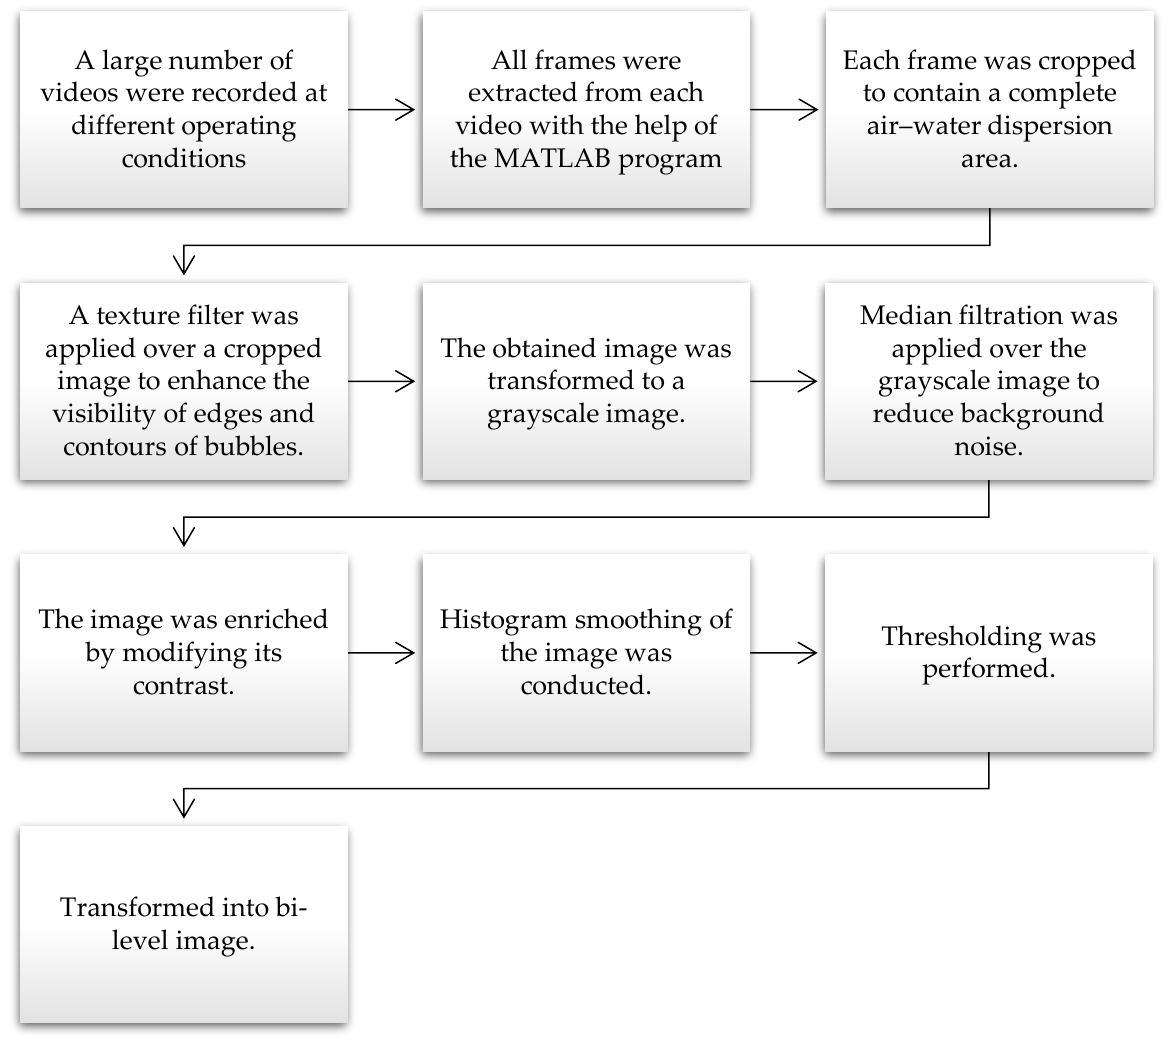
Figure 3. Steps for IP algorithm applied for detection of different zones of gas-liquid dispersion. The rangefilt was applied to enhance the visibility of edges and contours of bubbles. The imadjust function was used to enrich the contrast. The lowest 1% and the highest 1% of pixel intensities were saturated by the imadjust function. For smoothing, the adapthisteq function was used. Contrast enhancement limit 0.01 was considered for the adapthisteq function. The graythresh function was used to calculate the threshold value. Bi-level images obtained were used to derive information regarding the characteristics of the air–water dispersion in the reactor. In a bi-level image, the white pixel represents bubbles. Black pixels outside the bubbles represent water. Pixel intensity, PI, can